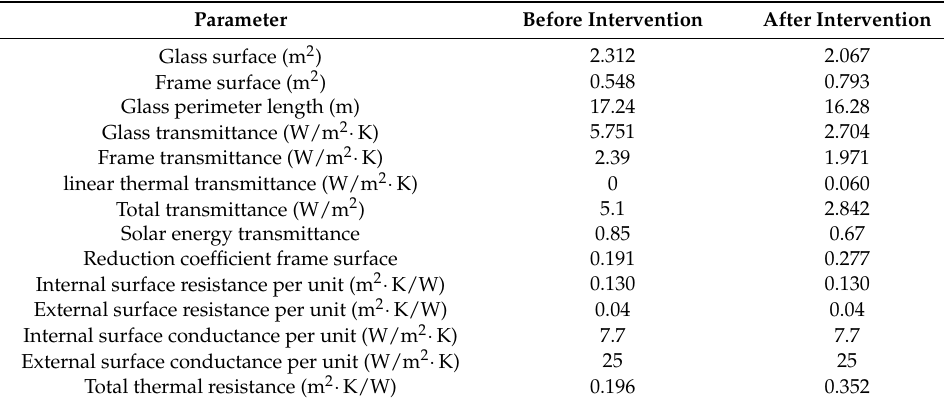
Table 5. Villa Sciarra fixtures stratigraphy before and after